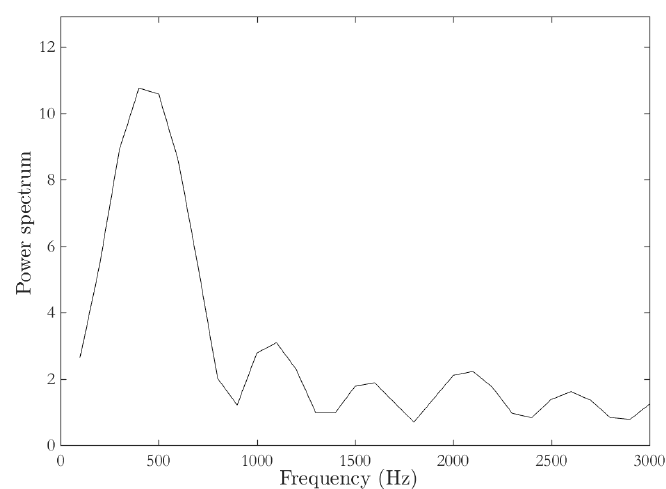
Figure 9. The power spectrum of the shear wave tracked by the 7.8 Mhz ( L 11 − 5 v ) transducer for the ex vivo liver sample using a Verasonics vantage system.